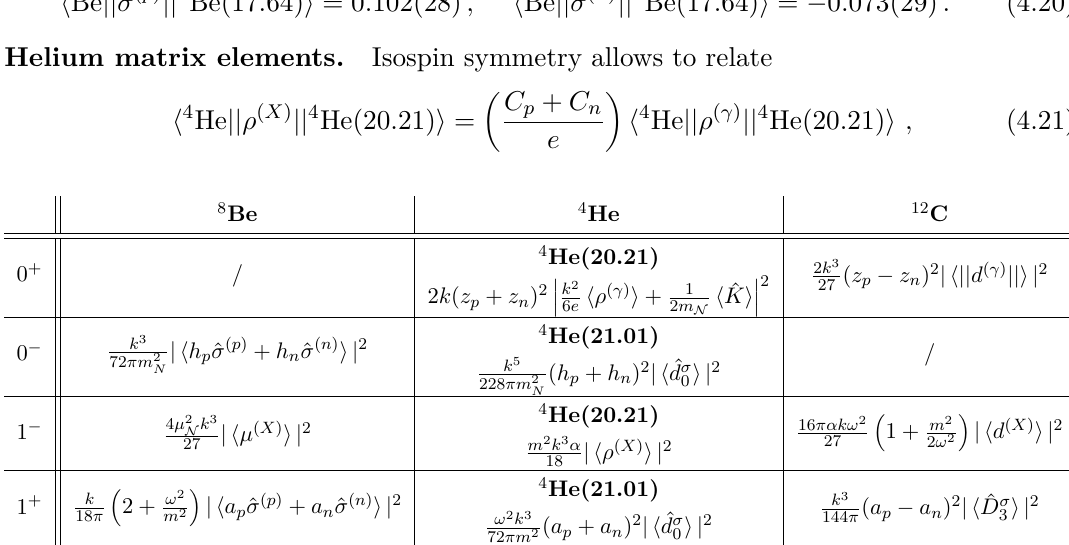
Table 4 . Decay rates for the 8 Be, 4 He and 12 C nuclear processes for the various spin assignment of the X boson. In the case of the Helium transition for each spin-parity possibility we indicate the 4 He excited state involved. In the expressions hOi represents the matrix element between the ground state and the excited nucleus of the corresponding operator, e.g. for the 12 C transition in the 0 + case h|| d ( γ ) ||i = h 12 C || d ( γ ) || 12 C(17 . 23) i . For the 4 He and 12 C cases we only report the non vanishing isoscalar and isovector contributions